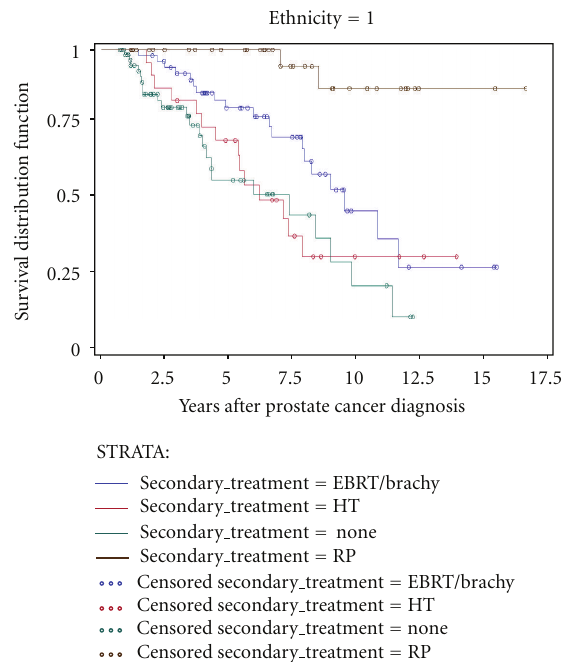
Figure 4: Kaplan Meier unadjusted estimation curve for overall survival among black men stratified by secondary treatment type among subjects with prostate cancer (CaP) followed on active surveillance (AS) for primary treatment ( n = 190).